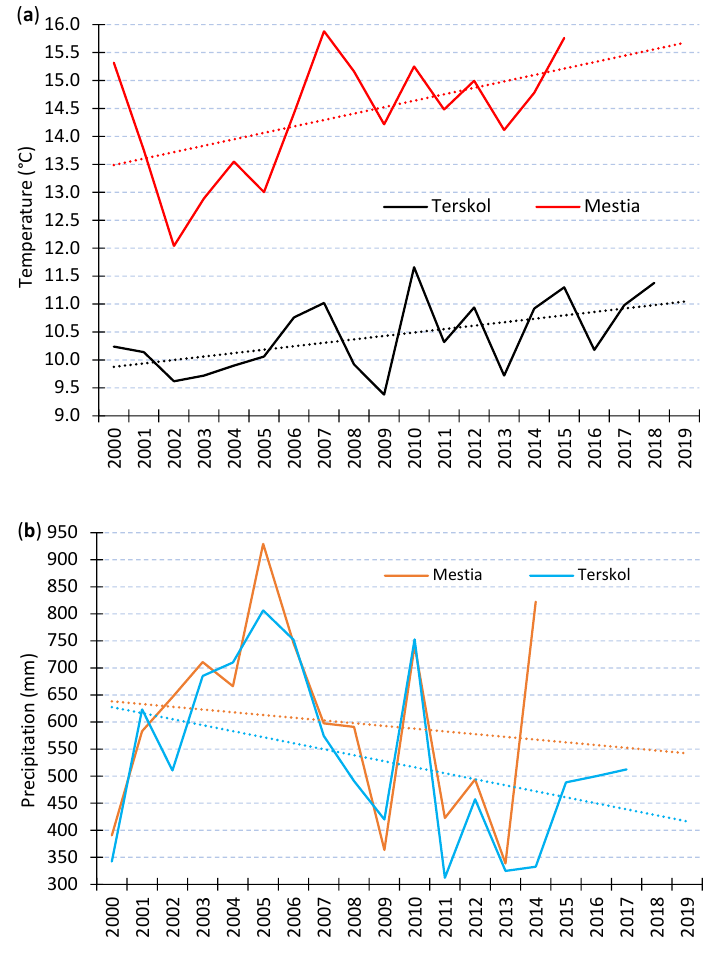
Figure 9. Mean annual May-September air temperatures ( a ) and sum of the October–April precipitation ( b ) at the Terskol and Mestia meteorological stations over the last twenty years. The dotted lines are the trend showing a temperature/precipitation course with time.